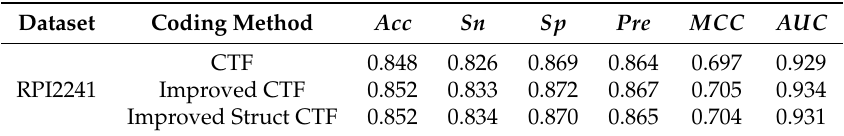
Figure 1. The flowchart of RPITER. The input of RPITER involves two sequence coding parts. The architecture of RPITER consists of four basic modules and an ensemble module. Dense-N means a fully-connected layer with N neurons, while Conv-M indicates a convolution layer with M filters. Table 1. Performance comparison between Conjoint Triad Feature (CTF) and our two improved coding methods on dataset RPI2241 by five-fold cross